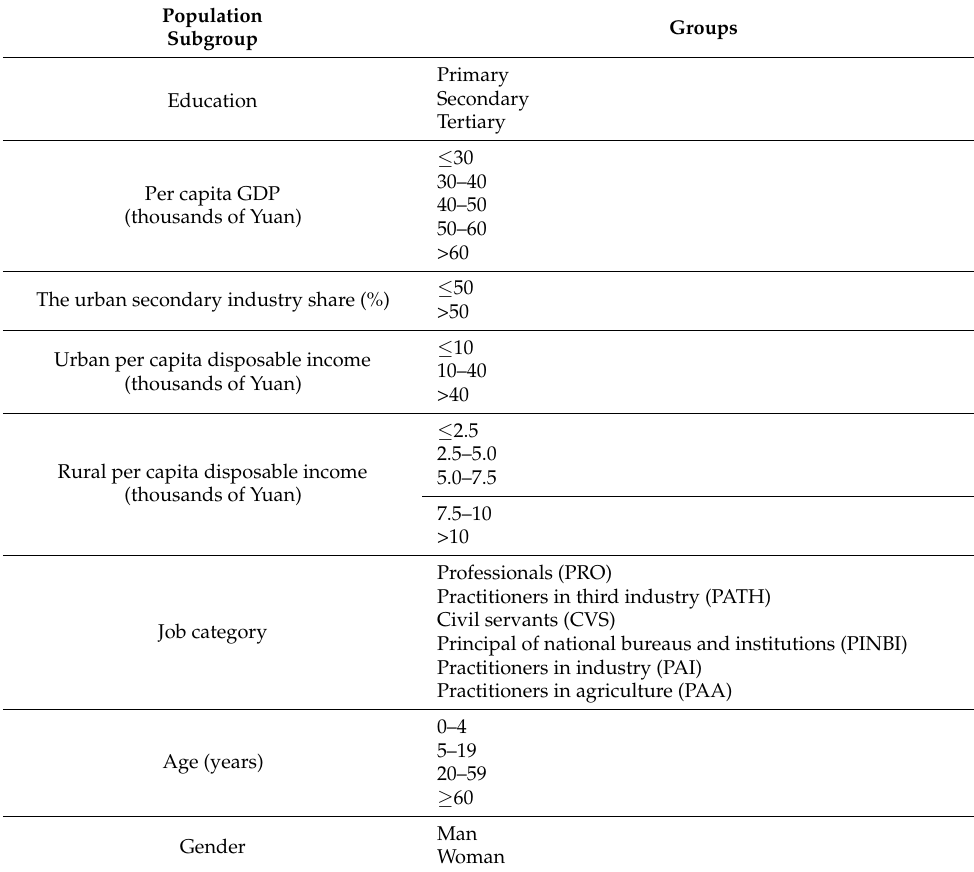
Table 1. The population characteristics of each population subgroup.